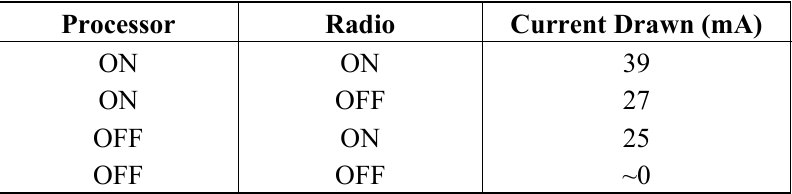
Table 1. Measured Current